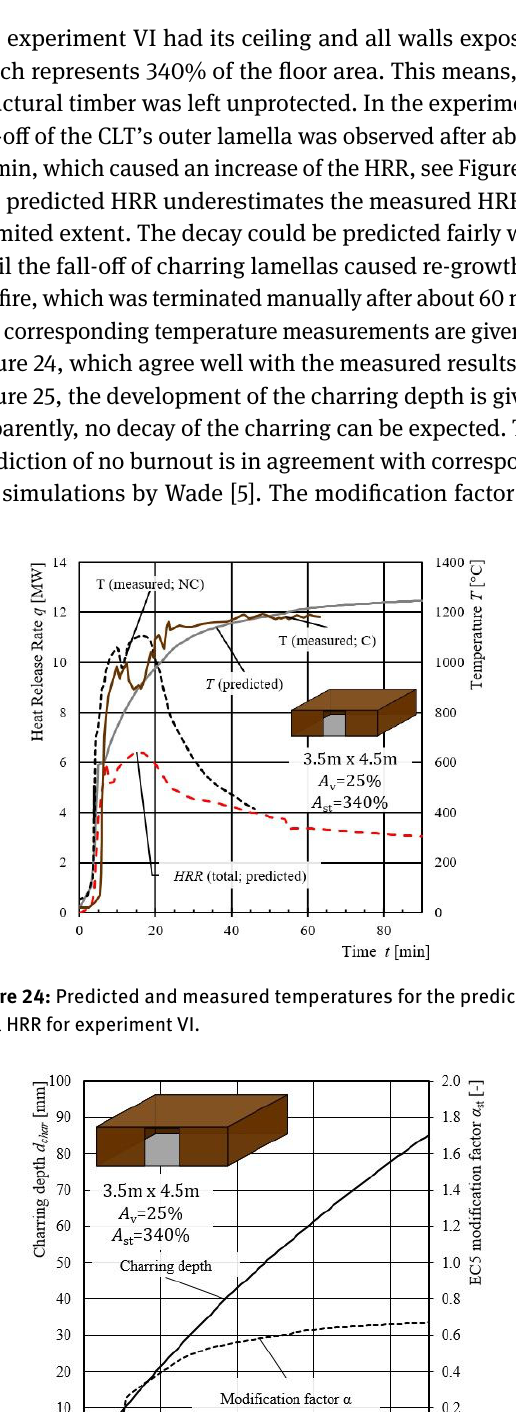
Figure 23: Predicted and measured HRR for experiment VI.